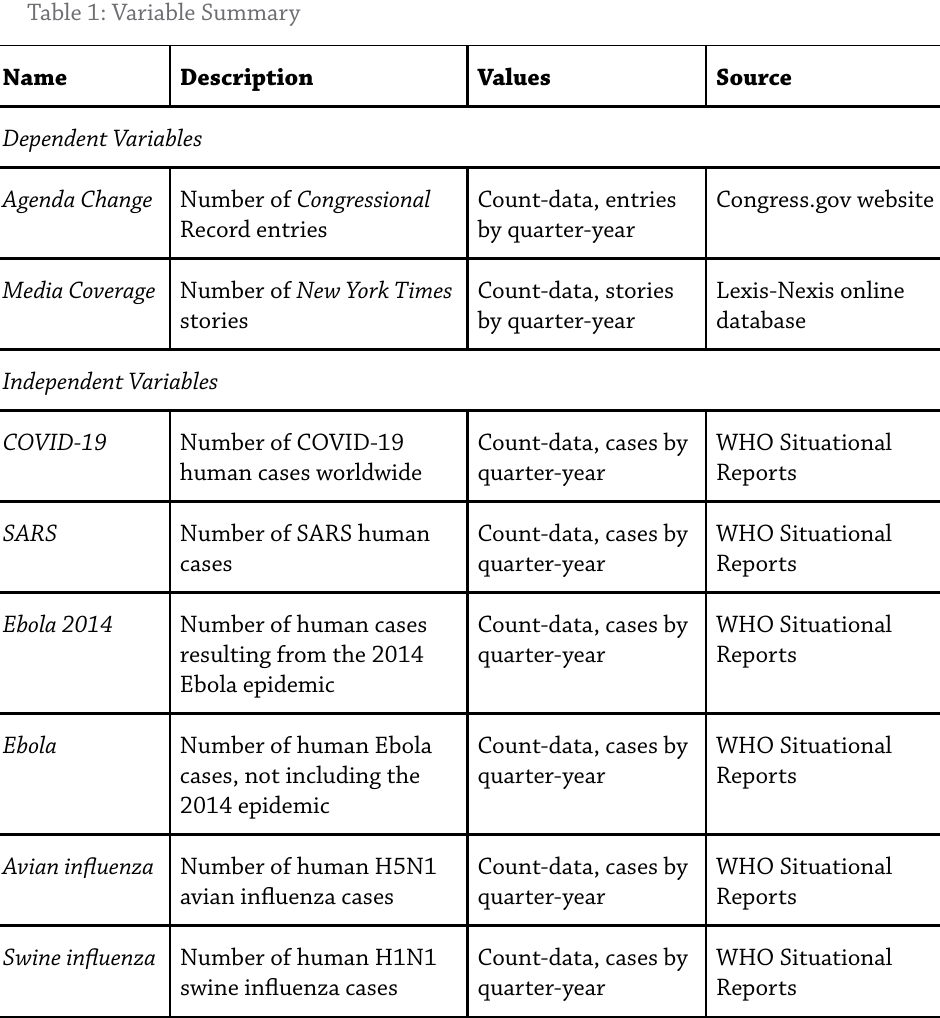
Table 1: Variable